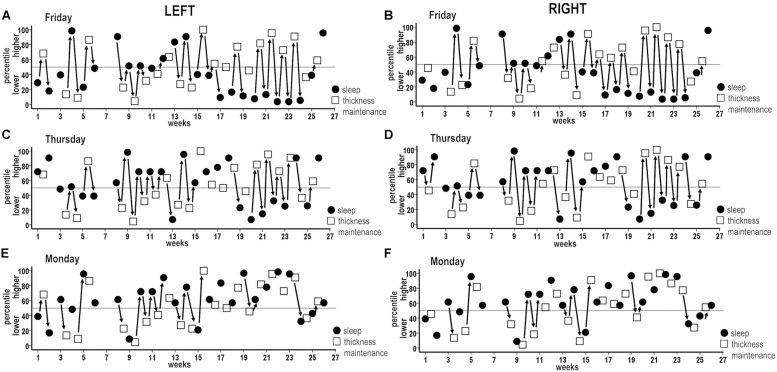
Combined plots of successive sequences of inverse associations between higher and lower and lower and higher percentile measures for individual night sleep durations (filled circles) and thickness maintenances (unfilled squares) across the study. Sequences of unidirectional relationships and bidirectional interactions are indicated (solid arrows) for respective left and right hemisphere thickness maintenances vs. Friday (A,B), Thursday (C,D), and Monday (E,F) night sleep durations. For each night, inverse sequences fitting the 50th percentile criteria were supplemented by intervening sequences that did not fit these criteria.